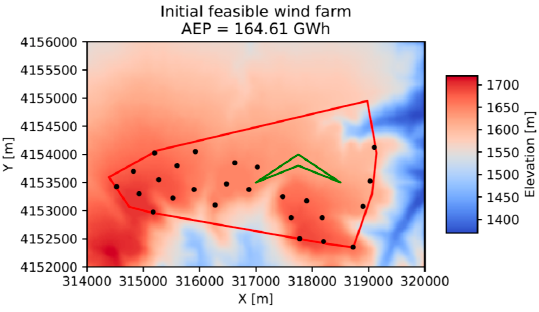
Figure 8. Initial design obtained by the Heuristic Fill algorithm.